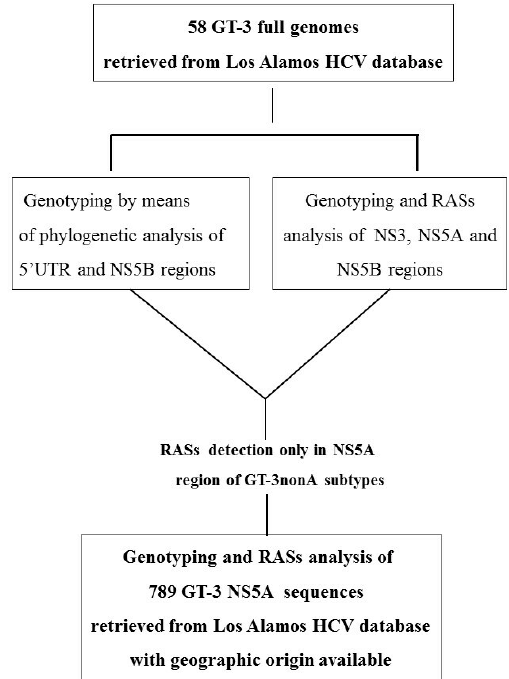
Figure 1. NS3, NS5A and NS5B resistance-associated mutation sites previously identified [11–13] and corresponding amino acid substitutions predicted with the Geno2Pheno algorithm. Substitutions are color-coded, based on genotype; red: GT-1; violet: GT-2; green: GT-3; blue: GT-4. Substitutions that confer resistance, according to Geno2Pheno classifications, are indicated in bold. The other substitutions reduced the susceptibility to NS5B inhibitors.